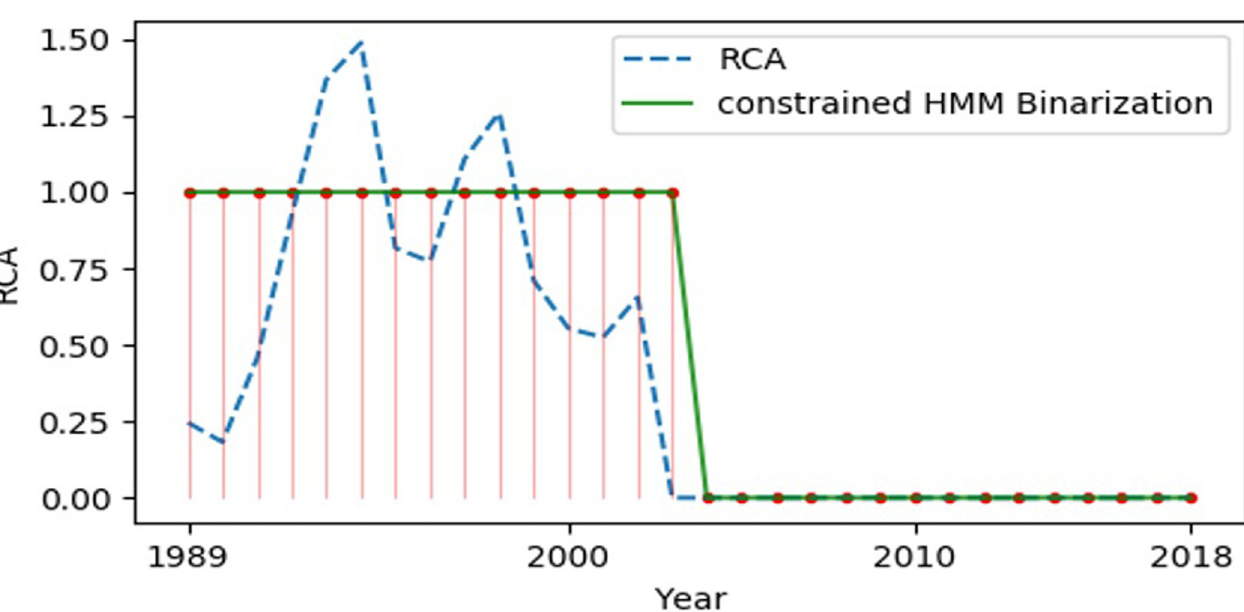
Fig 4. RCA raw data (RCA) and SDC-HMM data (constrained HMM Binarization). The data analysis is performed by comparing the RCA raw data (RCA) and the constrained HMM Binarization data (constrained 1-11VIM Binarization), in which the dotted line is the original RCA data and the solid line the constrained HMM Binarization